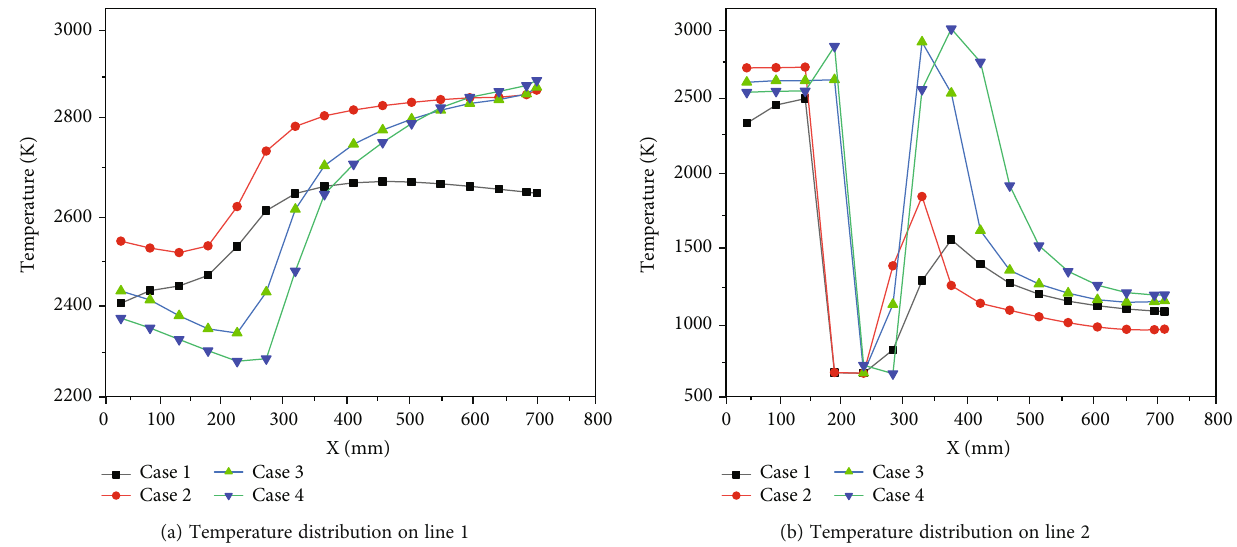
Figure 17: Temperature distribution on two marking lines. Line 1 is on the high temperature wall, while line 2 is on the low one.